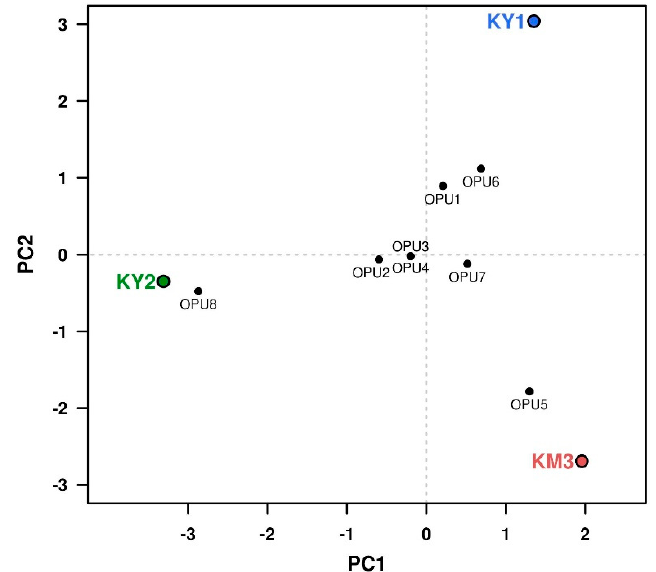
Figure 4. Principal component analysis (PCA) of the community profile for the clone libraries from three different areas, where the first (PC1) and second (PC2) components would explain the 67.04% and 32.96% of the variability, respectively. Operational Phylogenetic Units (OPUs) have been assigned to groups of clones with sequence identity ~99% or higher. The figure has been developed under an R programming environment.